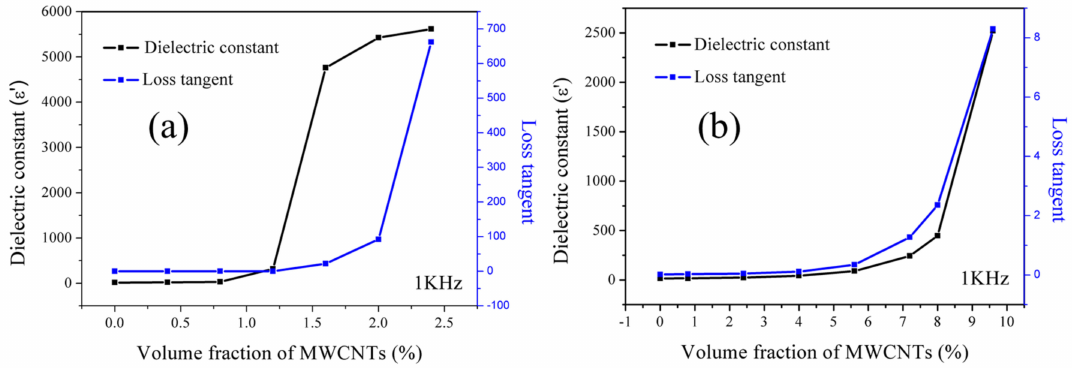
Figure 8. Dielectric parameters of ( a ) c-MWCNTs/PVDF and ( b ) c-MWCNTs/MG/PVDF composites with different c-MWCNTs contents measured at room temperature with the frequency of 1